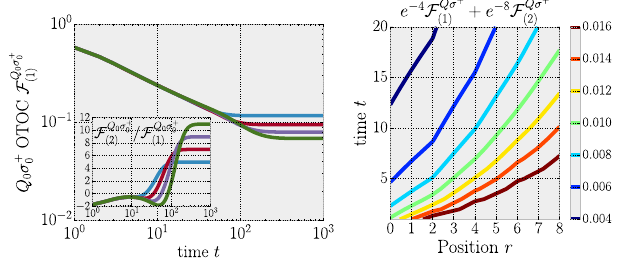
FIG. 16. Left: First nonvanishing contribution to the OTOC at order e − μ for system sizes L ¼ 16 , 20, 24, 28. This term decreases approximately as t − 0 . 4 until saturation. Inset: Ratio of the second- and first-order contributions shows nonmonotonic behavior. Right: Contour lines of the O ð e − 2 μ Þ for μ ¼ 4